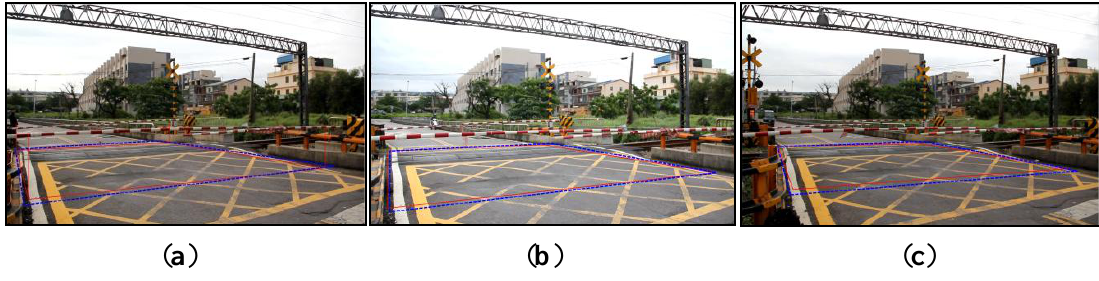
Figure 14. The detection result of the risk area corresponding to case-1 (Doudile Road); the blue-line area is the detection result, and the red-line area expresses the real measured result: ( a ) the measurement result with the camera mounted in the standard position; ( b ) the measurement result with the camera moved forward 50 cm; ( c ) the measurement result with the moved backward 50